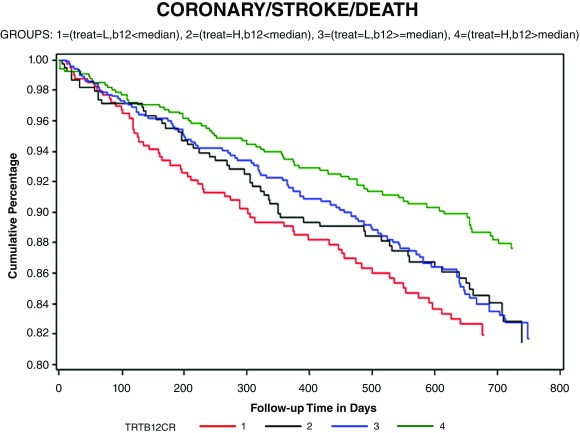
Kaplan-Meier survival free of stroke/myocardial infarction/vascular death in the Vitamin Intervention for Stroke Prevention (VISP) trial excluding patients who received vitamin B12 injections outside the randomized therapy and those with impaired renal function (estimated glomerular filtration rate <46 mL/minute/1.73 m²).Participants were stratified by the median baseline serum B12 level (to characterize the adequacy of B12 absorption) and by randomized allocation to low-dose B vitamins versus high-dose B vitamins (B6 25 mg, B12 400 μg, and folic acid 2.5 mg versus B6 200 μg, B12 6 μg, and folic acid 20 μg daily). The red line represents low-dose vitamins/B12 <median, the green line is high-dose vitamins/B12 above the median, the blue line is low-dose vitamins/B12 above the median, and the black line is high-dose B vitamins/B12 below the median. There was a 34% reduction of the composite endpoint of stroke/myocardial infarction/vascular death in the group with adequate B12 absorption receiving high-dose B vitamins (green line) and the group with less adequate B12 absorption receiving low-dose vitamins. The log-rank p value for all four groups was 0.02. CI, confidence interval; HR, hazard ratio. Reproduced by permission of Wolters Kluver from
42.